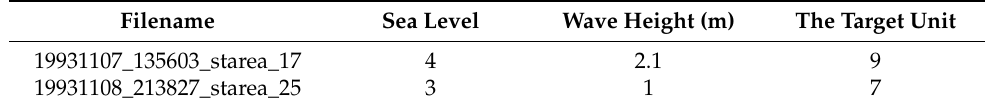
Table 4. The data information used in IPIX.